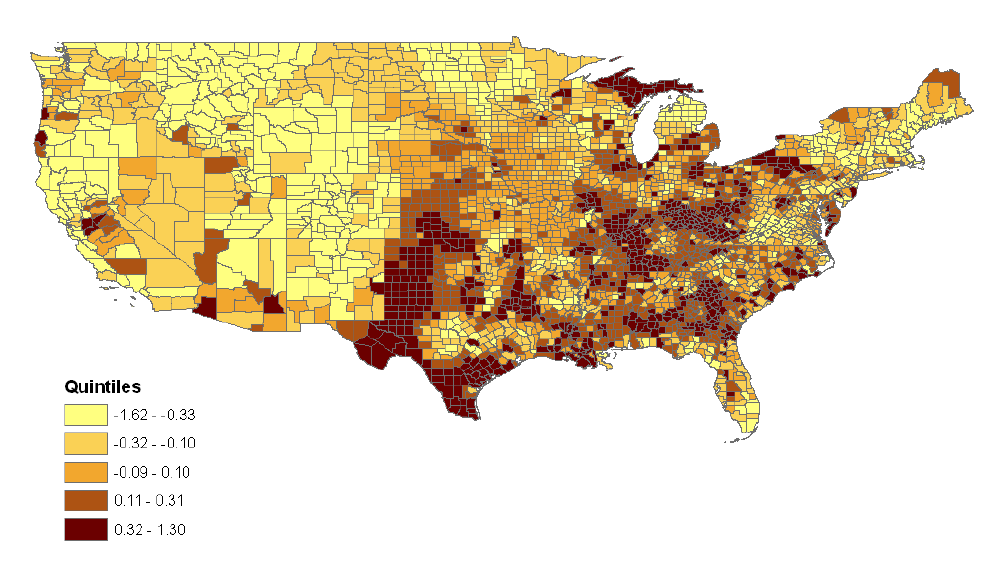
Figure 2 . County latent